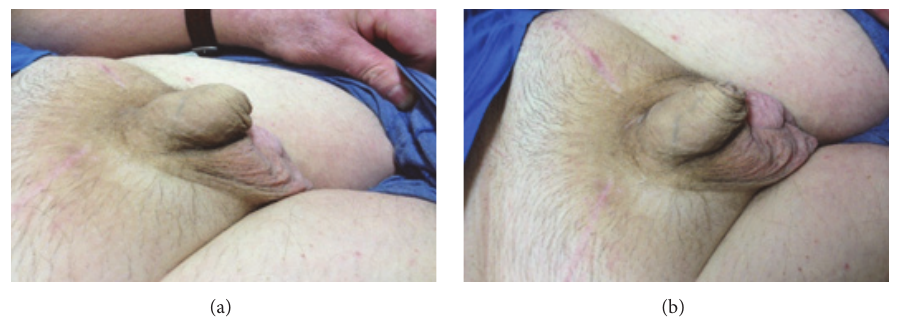
Figure 2: Lateral and anterior views of the scrotum after BEP